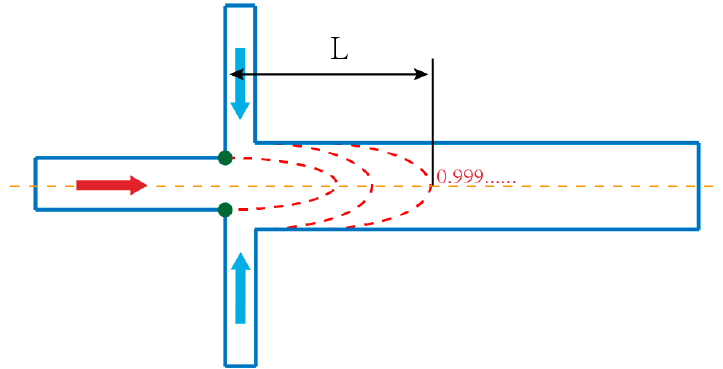
Figure 3. Definition of dispersion length in micromixing.